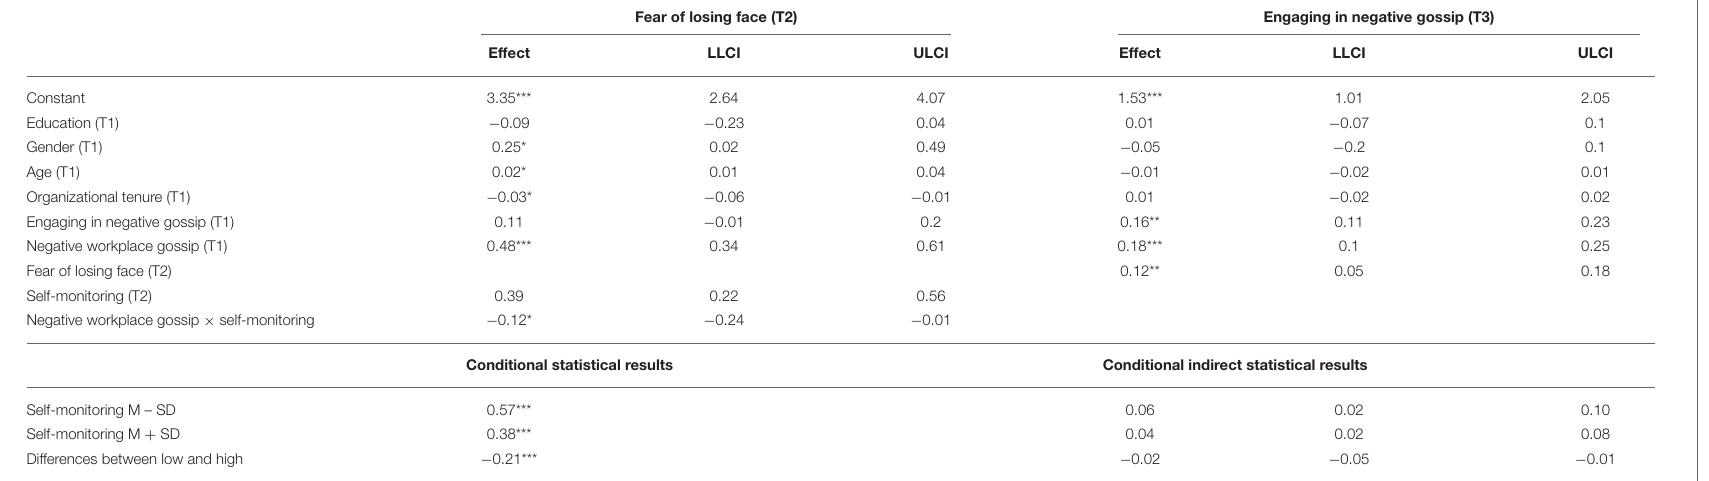
TABLE 4 | Regression results for moderation and moderated mediation model